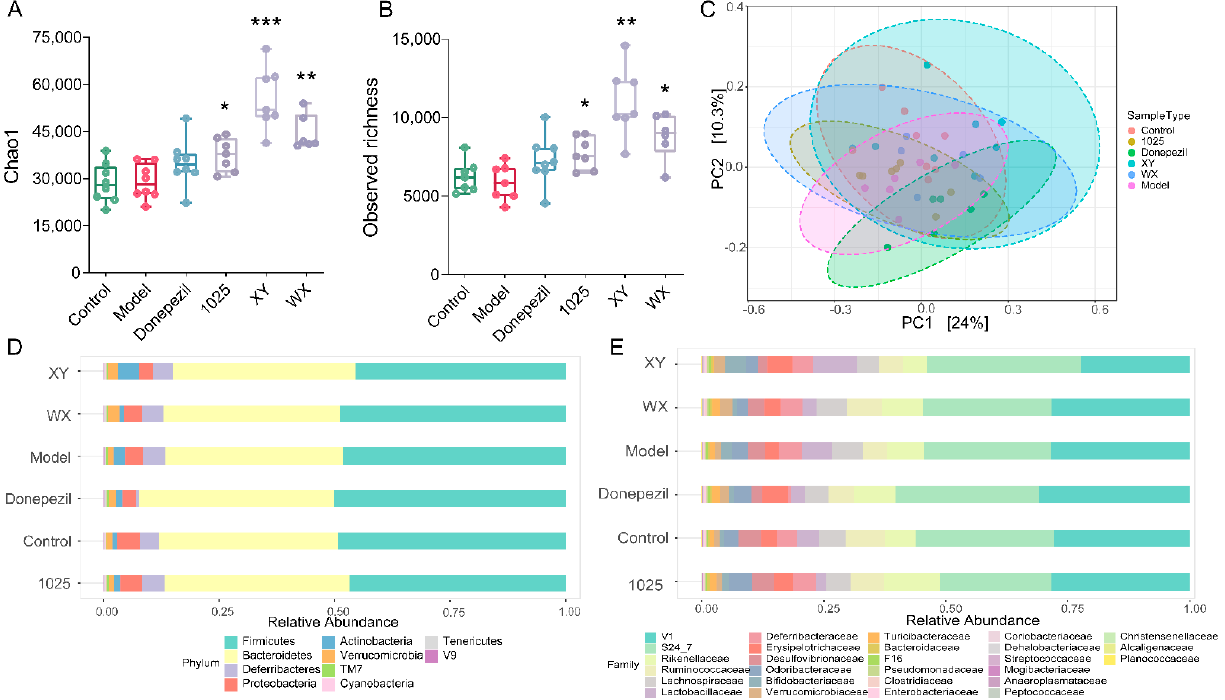
Figure 6. Bifidobacterium breve supplementation re-shaped the gut microbiome. ( A , B ) α -diversity was measured by Chao1 (left) and observed richness (right) ( n = 6–8). In the box plot, the bottom and top are, respectively, the 25th and 75th percentiles, and a line within the box marks the median. Whiskers above and below the box indicate the 1.5 interquartile range of the lower and upper quartiles, respectively. * p < 0.05, ** p < 0.01, *** p < 0.001 by one-way ANOVA for all groups. ( C ) Principal coordinate analysis (PCoA), based on Bray–Curtis distance, and PERMANOVA was used to test the difference in gut microbiota composition and diversity ( p < 0.001, R 2 = 0.29; n = 6–8 mice/group). ( D ) The microbial distribution of bacteria at the phylum level ( n = 6–8). ( E ) The microbial distribution of bacteria at the family level ( n =